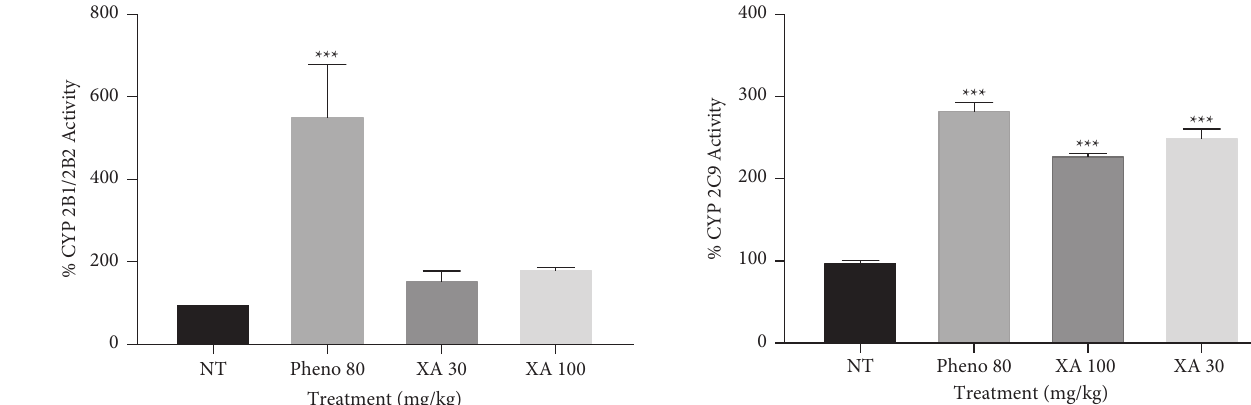
Figure 4: Effect of phenobarbitone (Pheno 80), xylopic acid low dose (30mg/kg; XA 30), and xylopic acid high dose (100mg/kg; XA 100) on CYP 2B1/2B2 enzyme. Data are presented as mean ± S.E.M. ∗∗∗ P < 0 . 001 compared to the no-treatment group (one-way ANOVA followed by Tukey’s post hoc test).